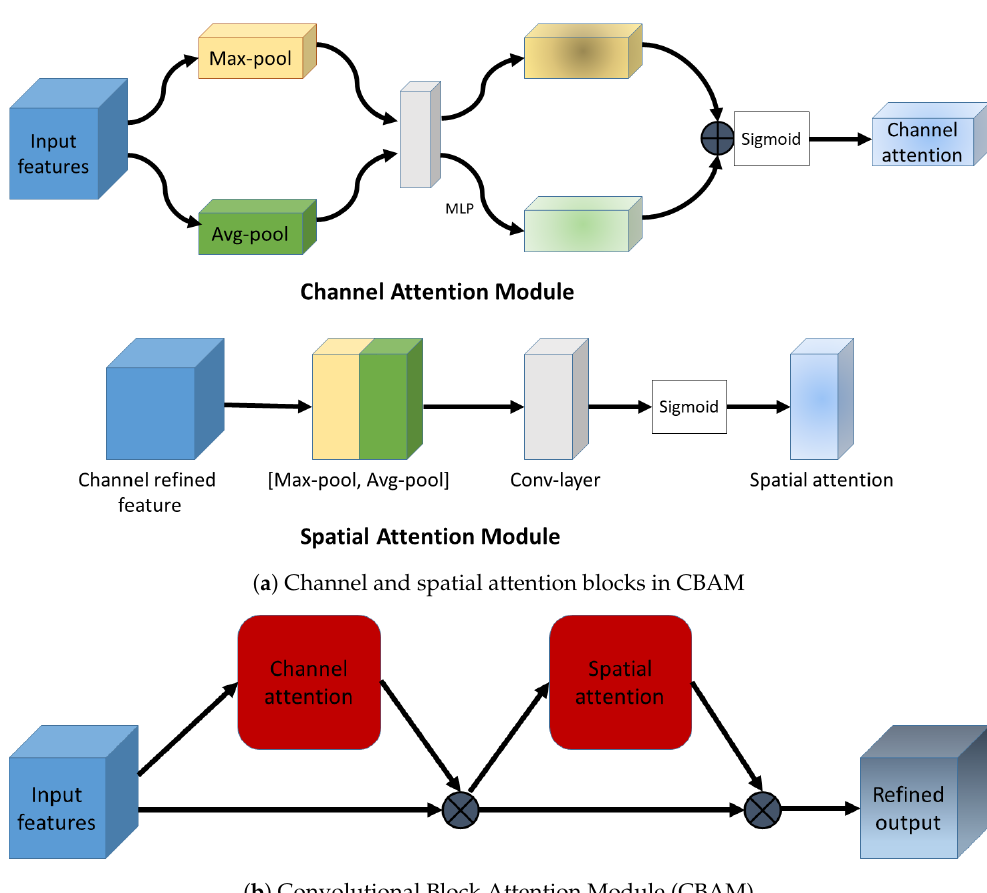
Figure 3. The scheme of the convolutional block attention module. ( a ) The channel attention module implements max and average pooling along the channel dimension. It produces a refined 1D channel attention vector. Meanwhile, the spatial attention module applies max and average pooling along spatial dimensions to produce a 2D spatial attention map. ( b ) The CBAM combines the channel and spatial attention maps (red-colored squares) detailed in ( a ) and applies them to the input feature map sequentially to produce an output feature map, which is refined along both the channel and spatial dimensions. Adapted with permission from Ref. [23]. 2018, Springer